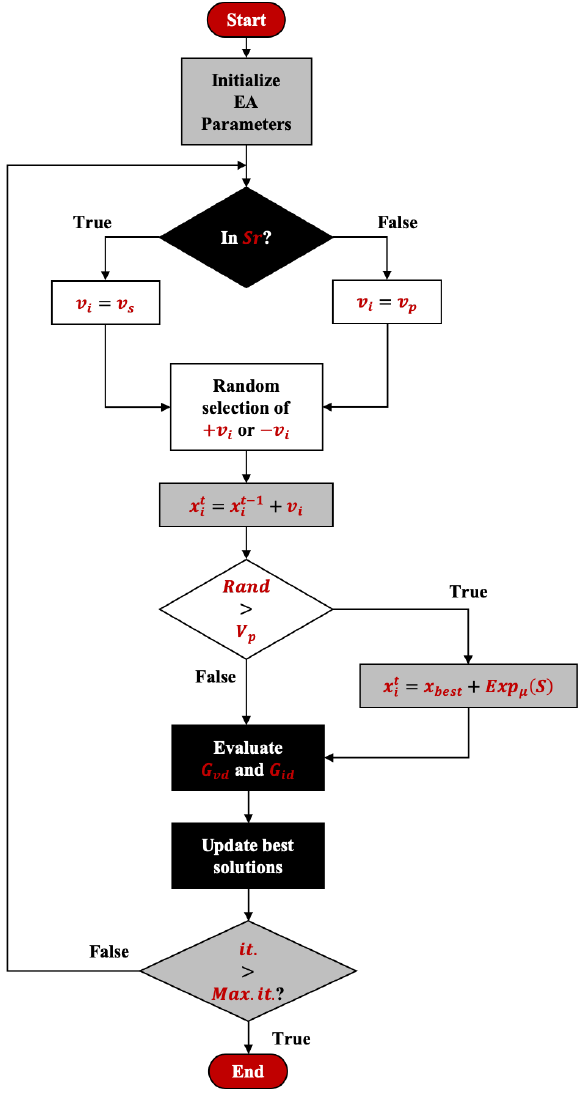
Figure 6. Basic flow chart of the Earthquake Algorithm (EA) for inductance